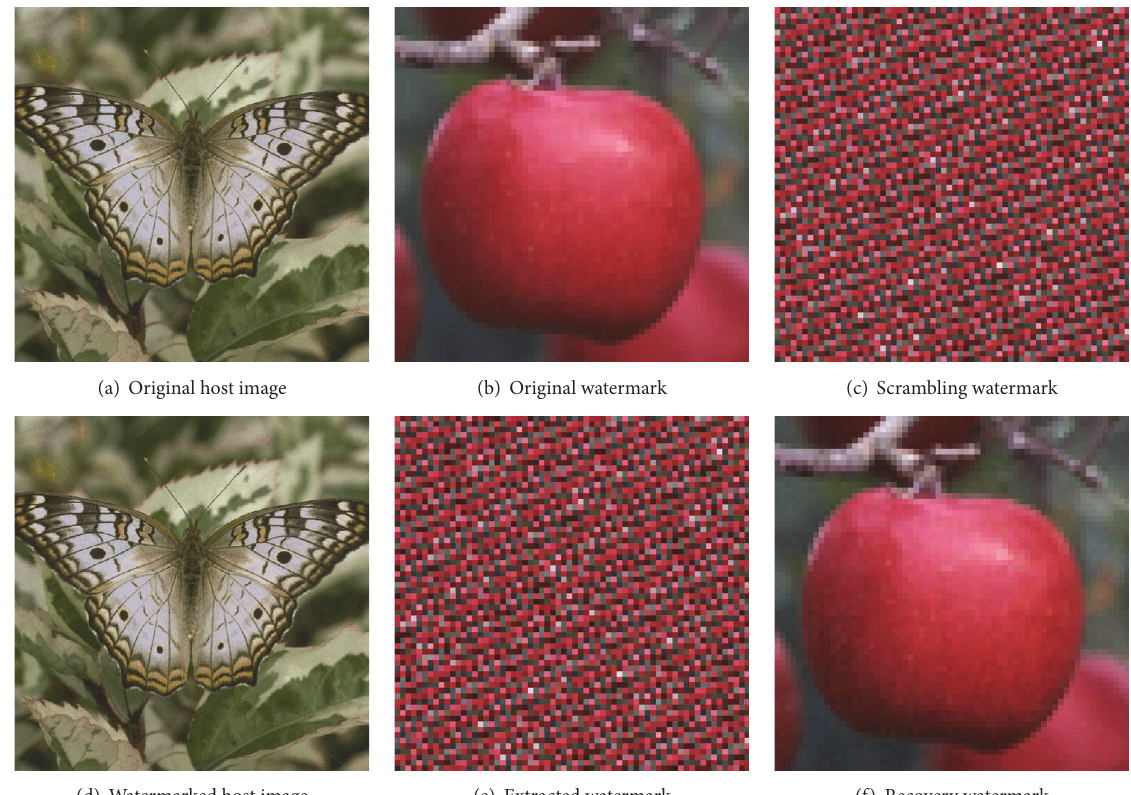
Figure 5: 1024 × 1024 host image with scale factor